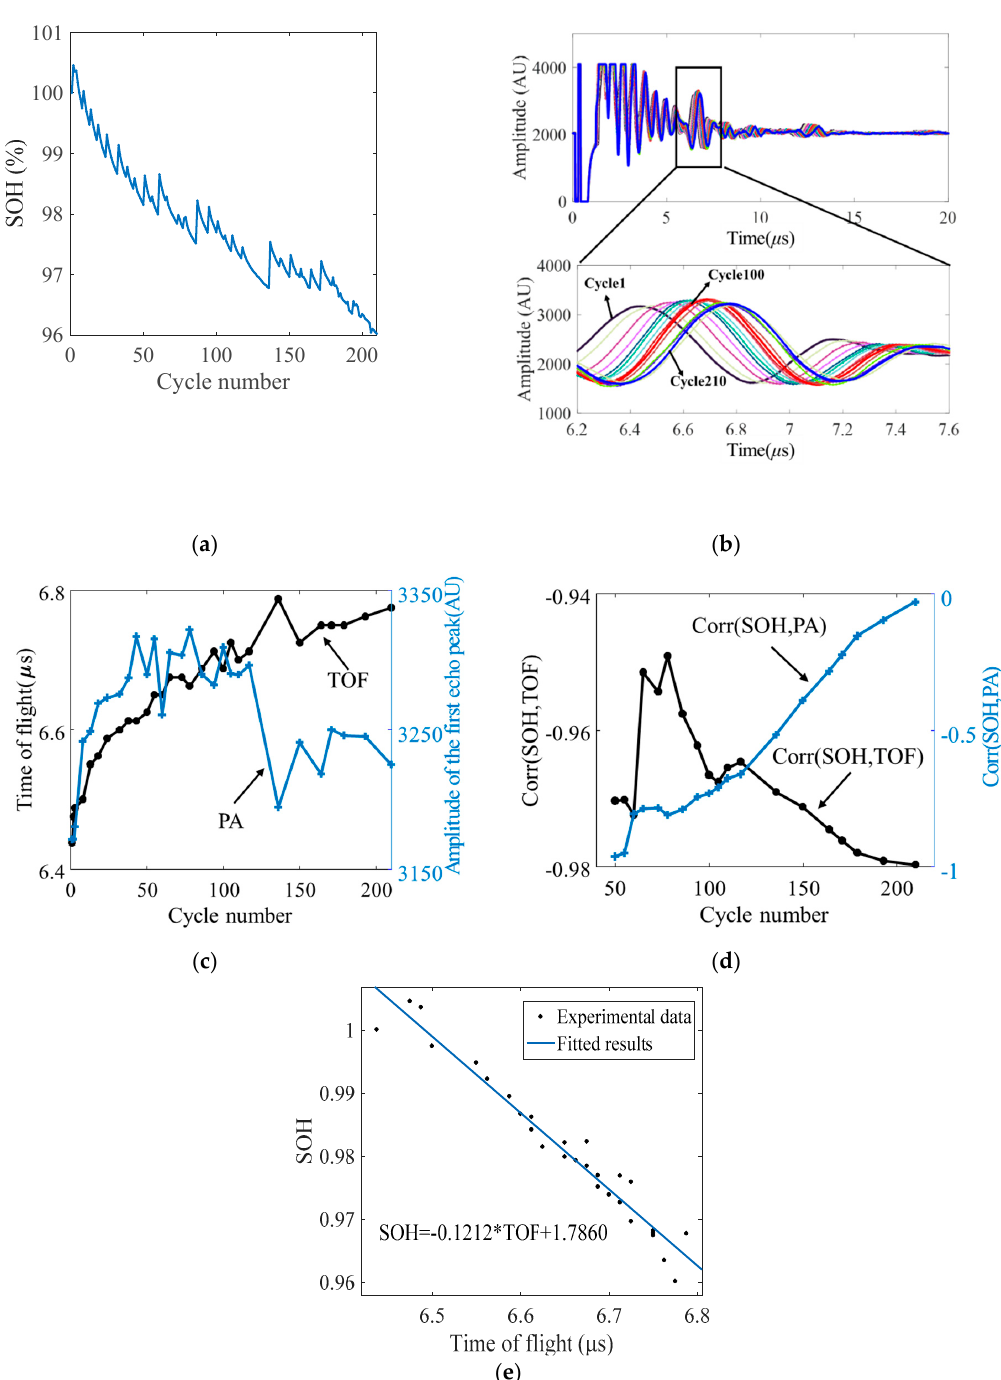
Figure 3. Cycling test results for battery A1: ( a ) cycling performance, ( b ) ultrasonic signals, ( c ) ultrasonic features, ( d ) Spearman correlations between the ultrasonic features and state of health (SOH), and ( e ) plot of SOH as a function of time-of-flight (TOF). Battery A2 underwent the same cycling test as A1. Figure 4a shows the cycling performance for battery A2. The capacity at cycle 63 is 98.35% of the initial capacity. Figure 4b,c shows the evolution of the TOF and PA, respectively, and their corresponding correlations with the battery SOH were also calculated. Both of these features show high correlations with the SOH. Figure 4d exhibits the relationship between the TOF and SOH of this battery. We observe that the TOF-SOH curve can also be well fitted using a linear model as battery A1. ( a ) ( d ) Figure 4. Cycling test results for battery A2: ( a ) cycling performance, ( b ) time-of-flight, ( c ) amplitude of the first echo peak, and ( d ) plot of SOH as a function of TOF. 0